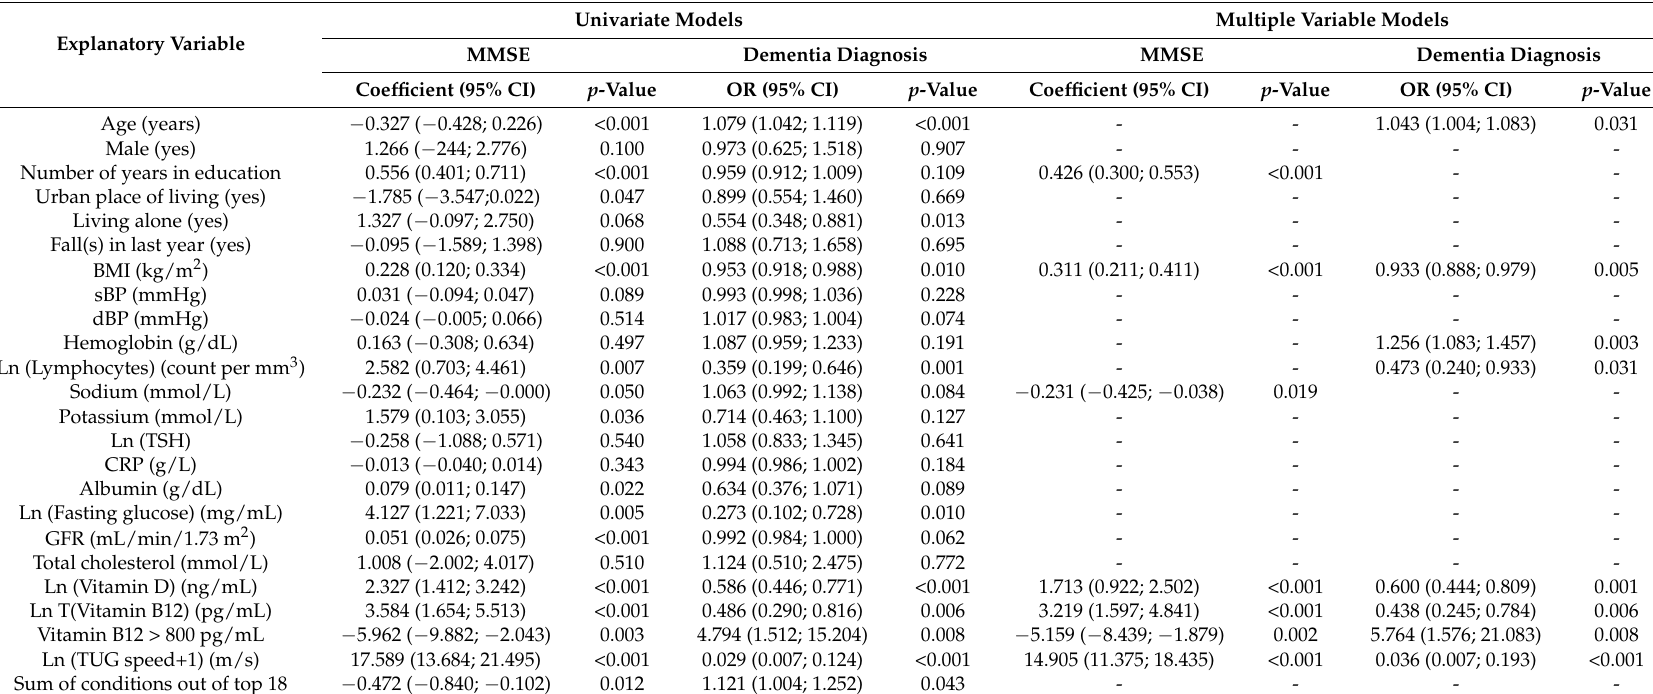
Table 2. The association between the sociodemographic or health-related characteristics of geriatric inpatients and the MMSE score/the clinical diagnosis of dementia. The results are from univariate and multiple regression